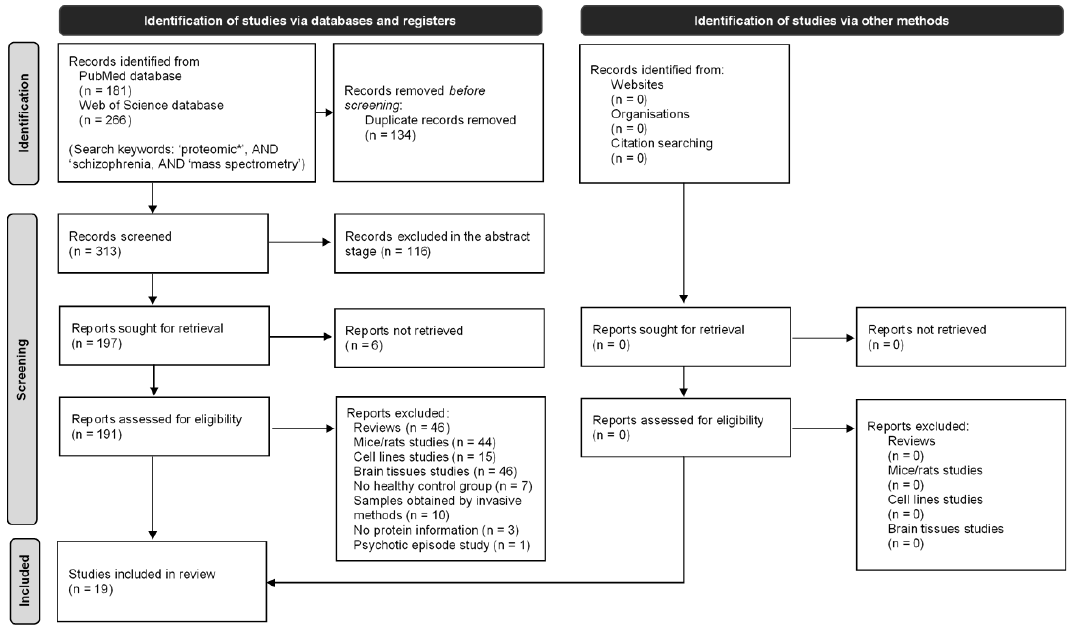
Figure 1. Flow chart of the selection process of the studies included in this systematic review of peripheral fluids MS-based proteomics in SCZ disorder, following PRISMA 2020 [54] .